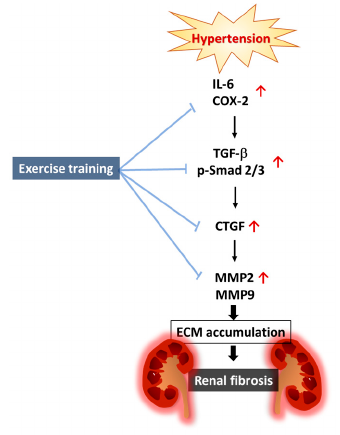
Figure 6. Proposed hypothesized diagram. Exercise training appears to suppress hypertension-induced renal cortical inflammatory components (IL-6 and COX-2), as well as the renal fibrotic pathway (TGF- β , p-Smad2/3, CTGF, MMP-9, and MMP2) and extracellular matrix (ECM) accumulation in hypertensive rat models.